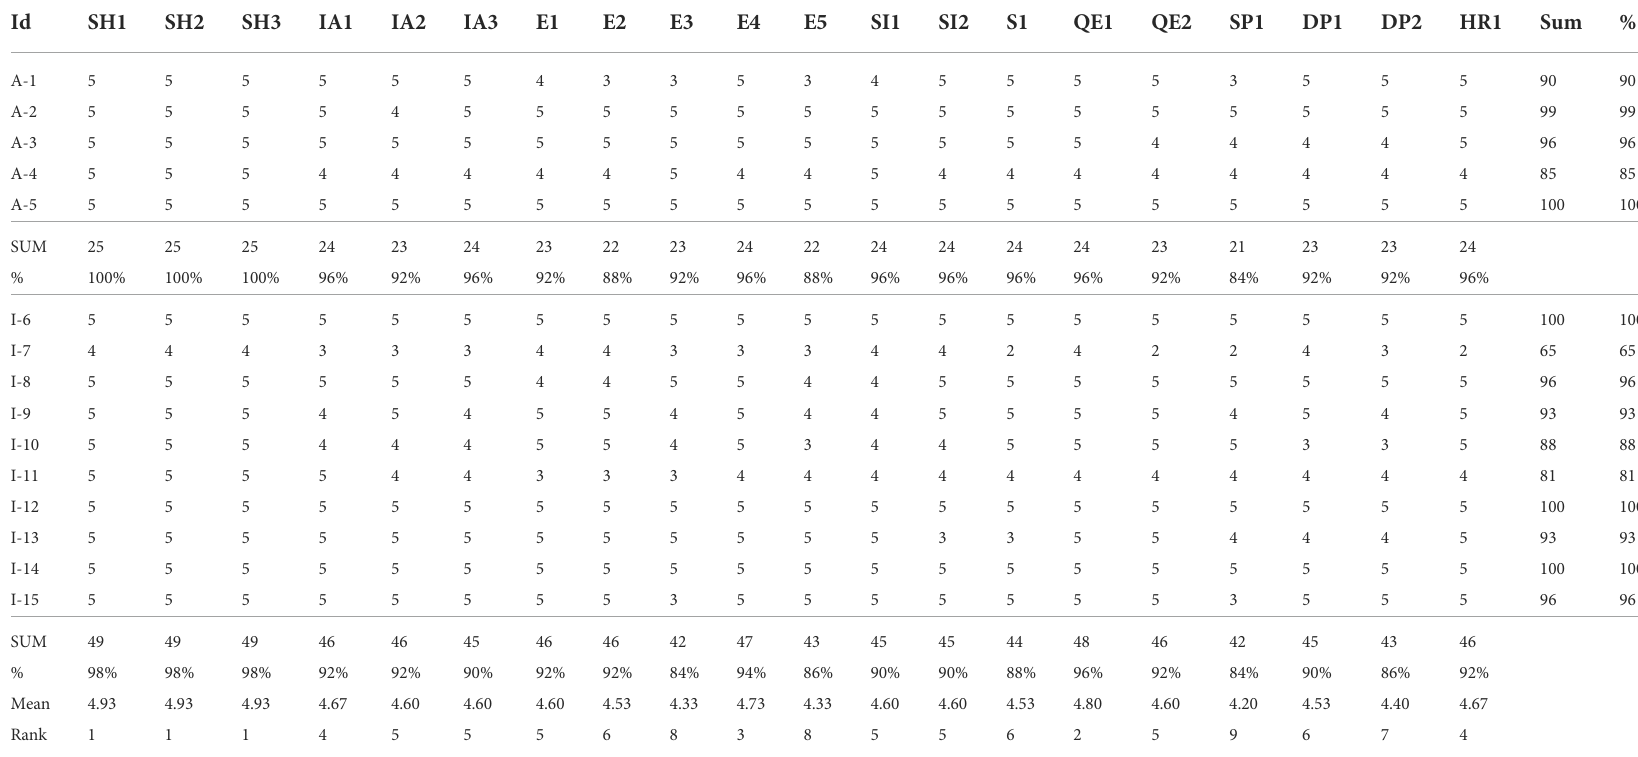
TABLE 5 Weighted Means and Ranks for Social Sustainability Attributes based on Perspectives.